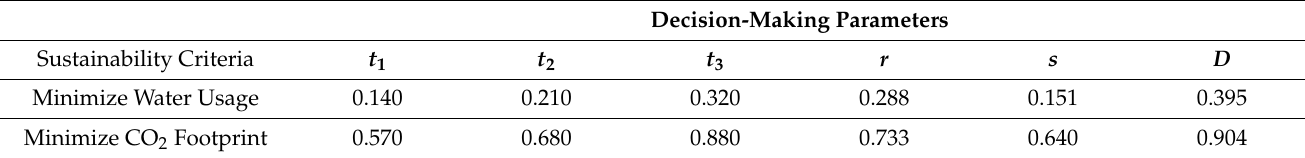
Table 1. Sustainability assessment of wooden materials.